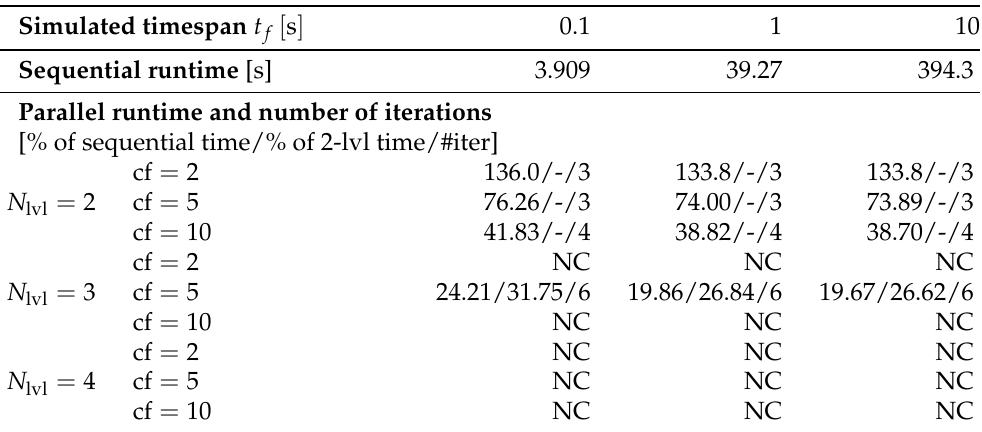
Table 2. Runtime of multi-level PinT compared to two-level and sequential time-stepping for the converter test case. Deterioration in convergence occurs for cases in which the coarsest time-step and switching period of the converter are not